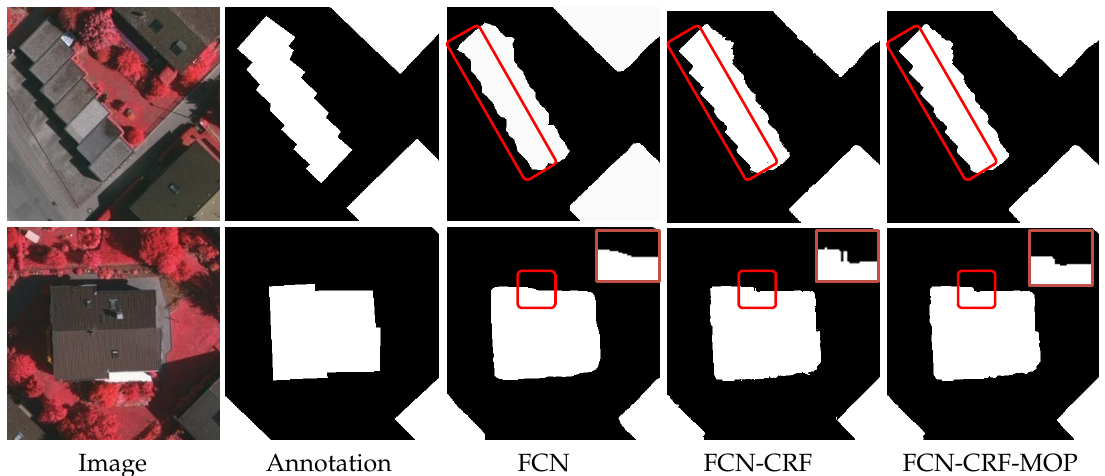
Figure 3. Segmentation results of the Fully Convolutional Network (FCN), the FCN with fully-connected Conditional Random Fields (FCN-CRF), and the DeepLab model with a CRF post-processing step and the morphological opening operation for flaw removal, denoted as FCN-CRF-MOP.